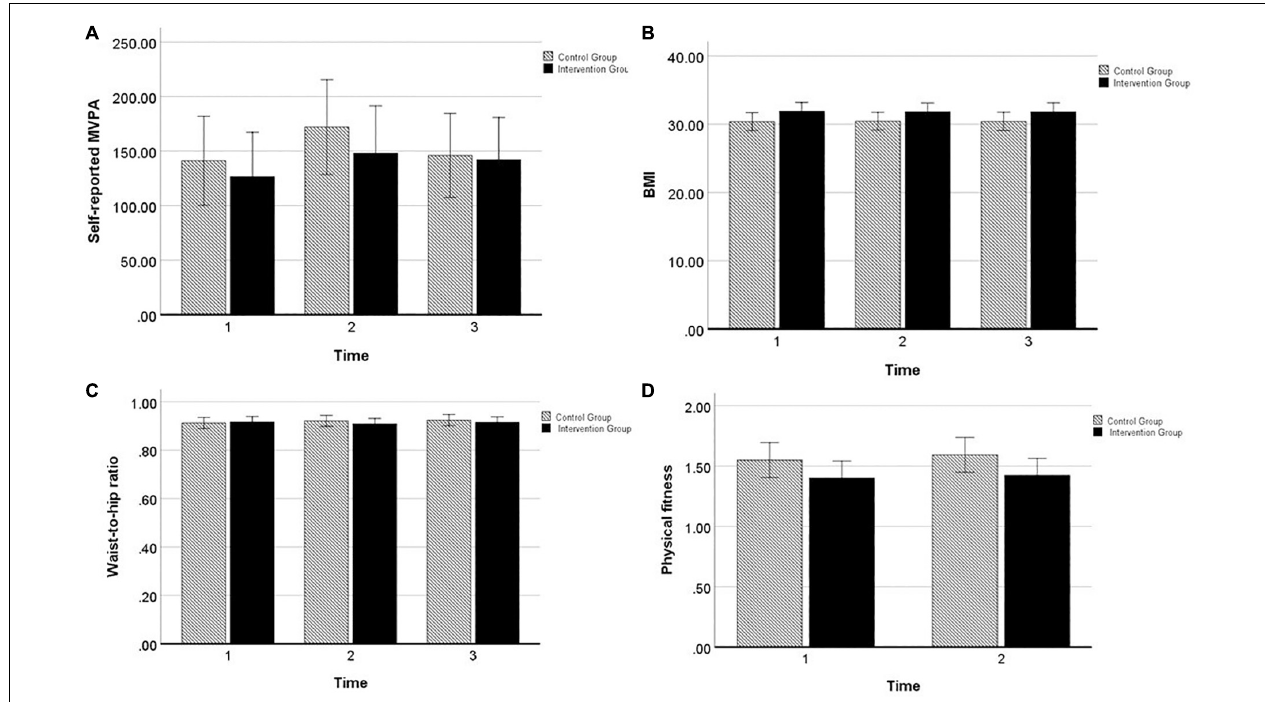
FIGURE 2 | Profile plots from two-way mixed ANOVA’s of estimated marginal means of target persons’ (A) self-reported MVPA, (B) BMI, (C) waist-to-hip ratio, and (D) physical fitness, displayed for intervention group (black) and control group (black–white striped) with 95% confidence interval error bar.